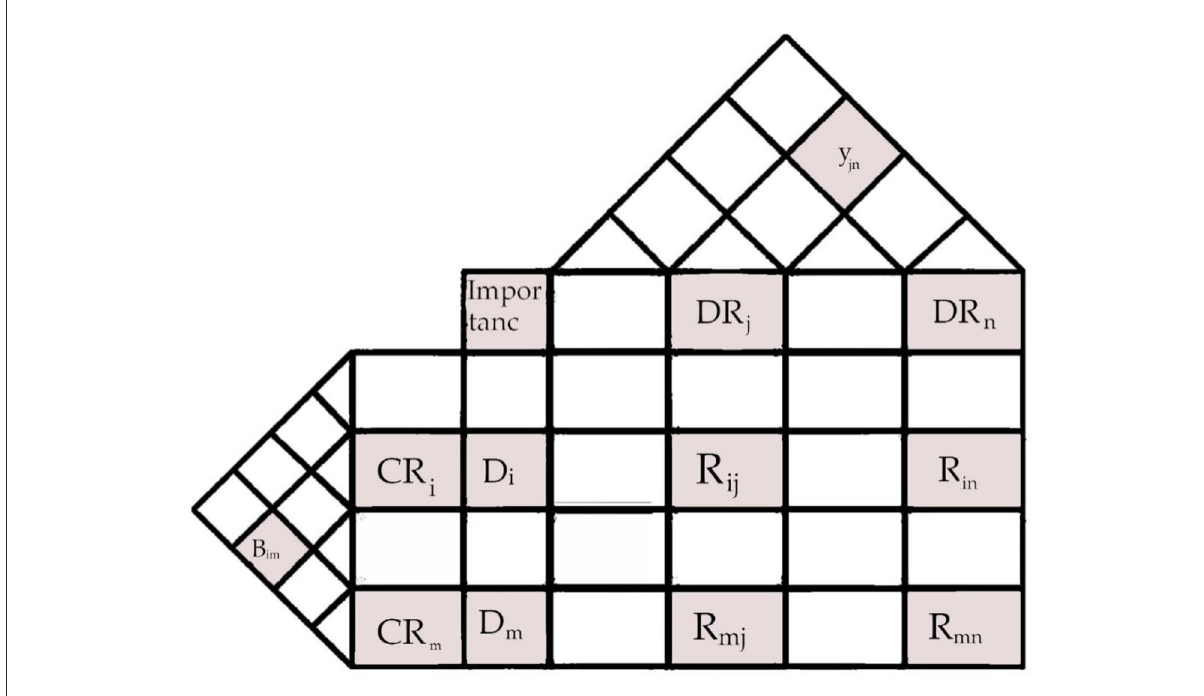
FIGURE1 General HOQ